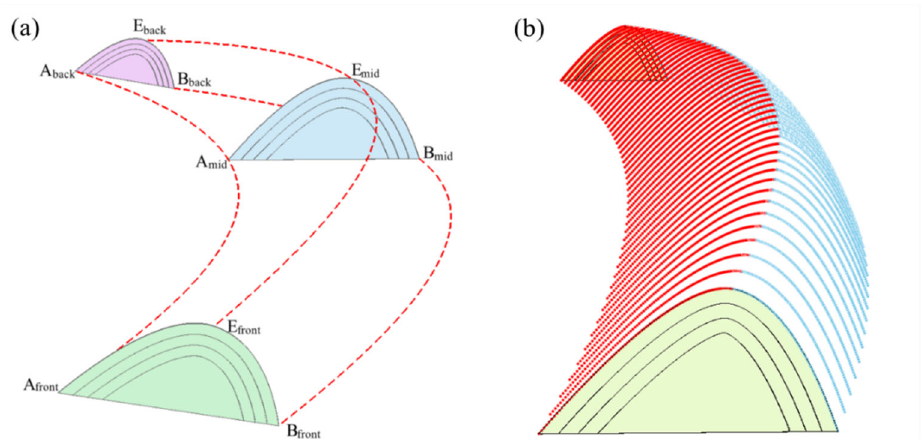
Figure 11. Interpolation of transition sections based on morphing, ( a ) constraint boundaries for morphing interpolation, and ( b ) point set of transition sections. The point sets of two colors are the results of morphing interpolation, respectively.